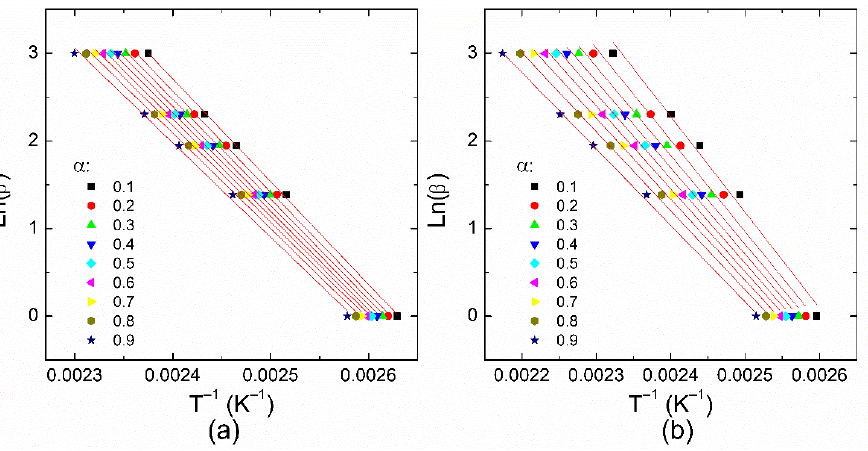
Figure 5. Flynn–Wall–Ozawa plots at different conversion degrees for ( a ) reaction 1 and ( b ) reaction 2. Fitting lines are also shown as red lines.